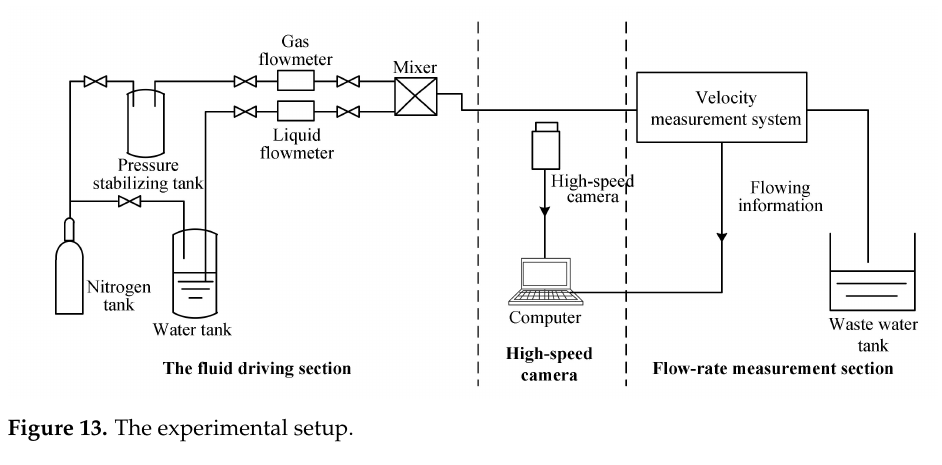
Figure 13. The experimental setup.